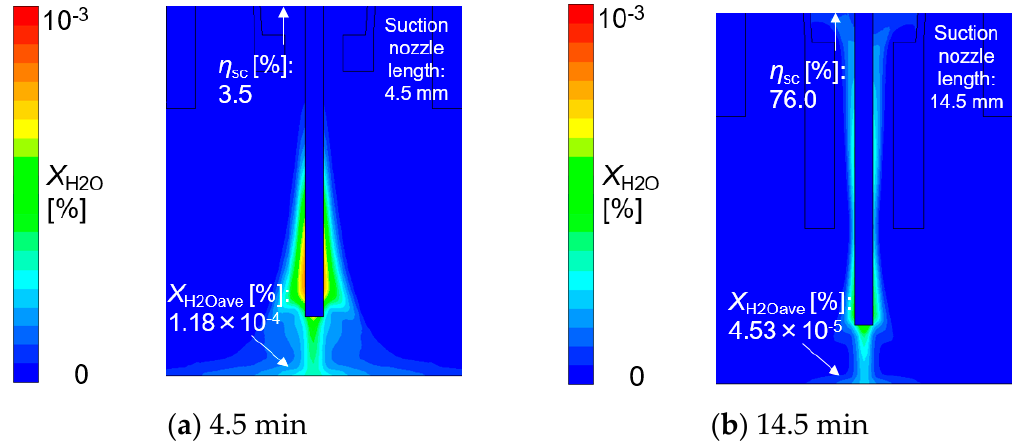
Figure 16. The effect of suction nozzle length on the mole fraction of H 2 O: ( a ) 4.5 mm, ( b ) 14.5 mm.